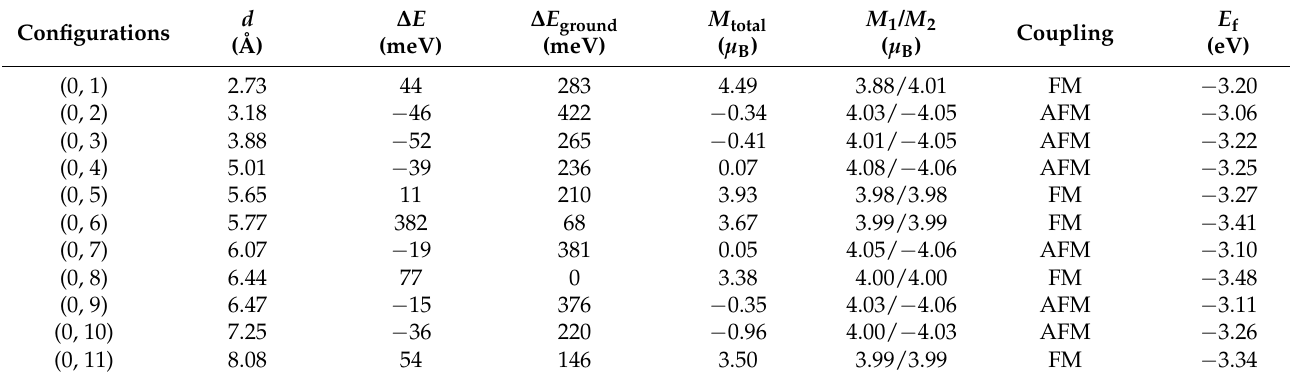
Table 2. The relaxed Mn–Mn distance ( d ), the energy difference ( ∆ E ) between FM and AFM states, the energy relative to the ground state ( ∆ E ground ), the total magnetic moment of the supercell ( M total ), the magnetic moments of two Mn dopants ( M 1 and M 2 ), and the formation energies ( E f ) for various double Mn-doped